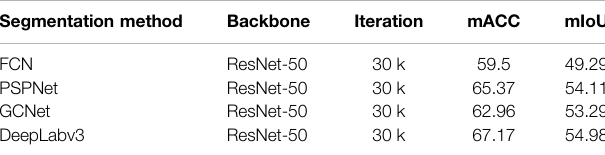
TABLE 4 | Benchmark results in our dataset for the segmentation